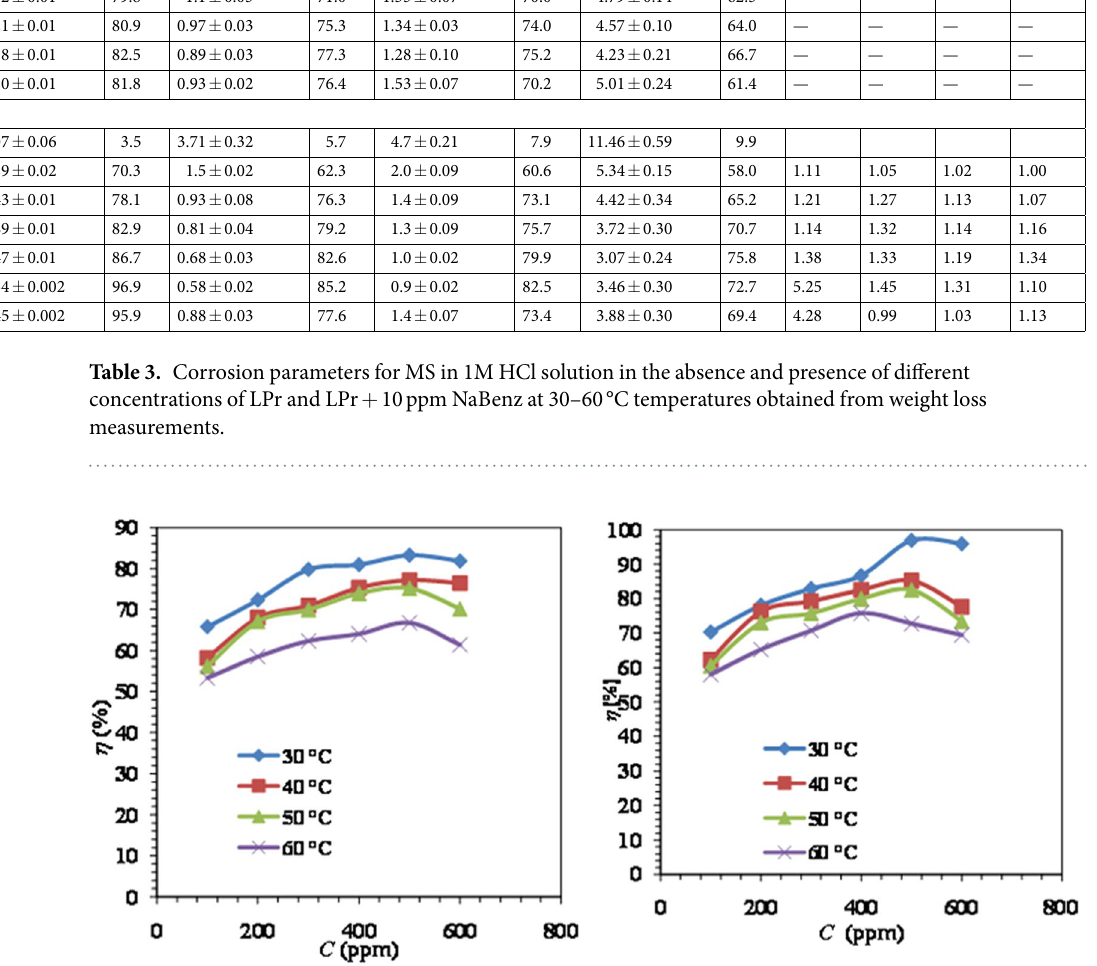
Figure 7. Variation of inhibition efficiency ( η w %) vs. temperature (°C) ( a ) LPr and ( b ) LPr + 10 ppm